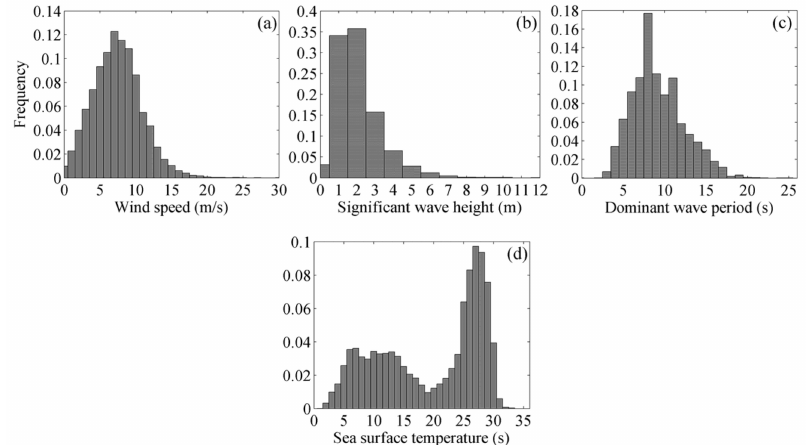
Figure 2. Histograms of the buoy observations co-located with Ku-band precipitation radar (KuPR): ( a ) wind speed, ( b ) significant wave height, ( c ) dominant wave period, ( d ) sea surface